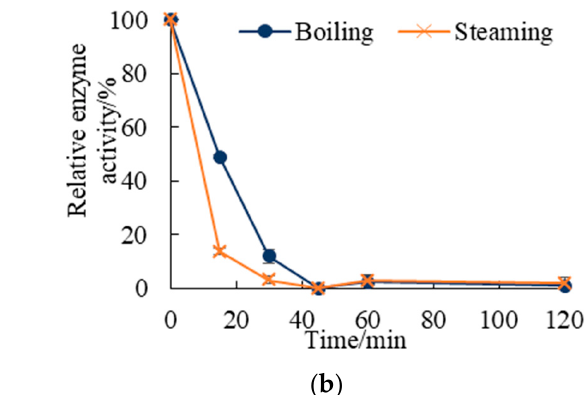
( b ) Figure 7. Principal component PC1 and PC2 scores plot ( a ) and component plot in rotated space from the principal component analysis of C. frondosa samples ( b ) assessing the effects of blanching, boiling, and steaming at different temperatures and cooking durations. Raw is sample without heating treatment. The body wall of the raw C. frondosa had high mechanical strength (hardness). During the blanching process, 60 °C was a key temperature for the physicochemical quality of C. frondosa . When the blanching temperature was below 60 °C, the water content and autolysis enzymes activity were comparable to that of the raw sea cucumber. When above 60 °C, the protein denatured but crude protein content increased because of drip loss. It resulted in the increase in chewiness, and the decrease in hardness, hence improving the palatability of C. frondosa . However, since the enzyme was not fully